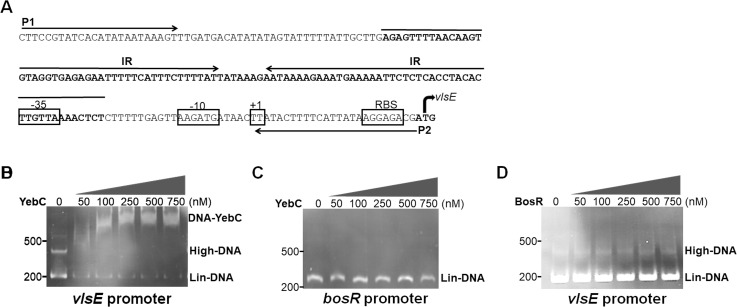
YebC binds to the vlsE promoter.A. Promoter sequence of the vlsE promoter. P1 and P2 are the primers used for PCR amplification of the DNA fragment for electrophoretic mobility shift analyses (EMSA). The inverted repeat sequences are labeled IR. -35 box of the vlsE promoter overlaps with the right arm of the IR. EMSA were performed using various concentrations of recombinant YebC (B and C) or BosR (D) proteins incubated with 50 nM of DNA fragments from 200 bp upstream of the vlsE promoter region or 300 bp upstream of the bosR promoter region (serving as a negative control). All the EMSA reactions include 0.01mg/ml BSA to prevent non-specific binding. Binding reactions were carried out for 30 min at 25°C, and then separated on a 5% polyacrylamide gel and stained with ethidium bromide. The band corresponding to the linear form DNA fragment (Lin-DNA), the higher form DNA (High-DNA), and the DNA-YebC protein complex (DNA-YebC), are labelled on the right.